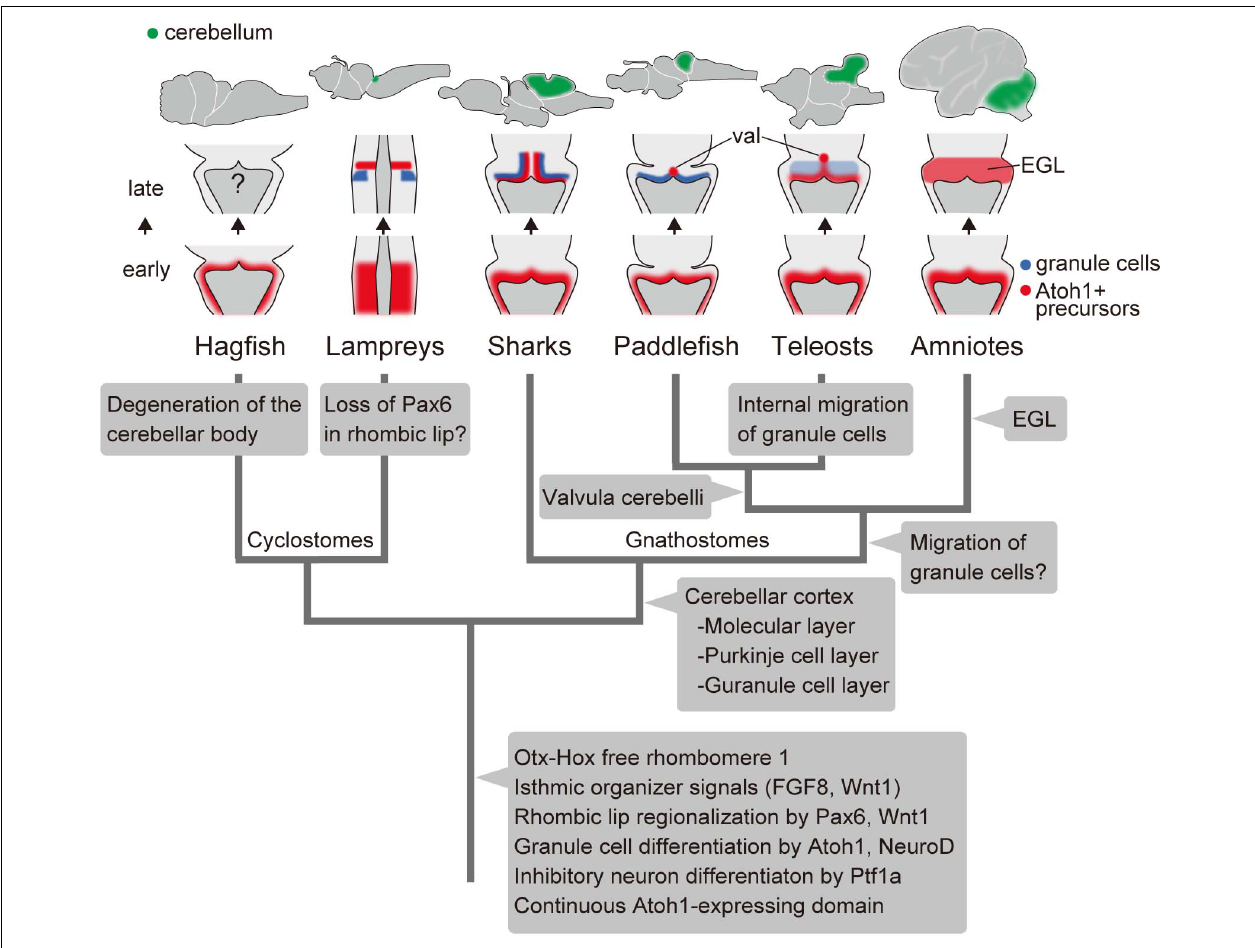
FIGURE 4 | An evolutionary scenario for the vertebrate cerebellum, based on Chaplin et al. (2010) and Butts et al. (2014c) and the present study. Note that the internal migration of postmitotic granule cells has been observed in teleosts but not in the paddlefish. Therefore, it is equally possible that this migration of granule cells was acquired after the divergence of chondrichthyans and osteichthyans, with paddlefish losing this ability secondarily. Alternatively, it is possible that teleosts acquired the migration independently from amniotes. val, valvula cerebelli; EGL, external granule cell